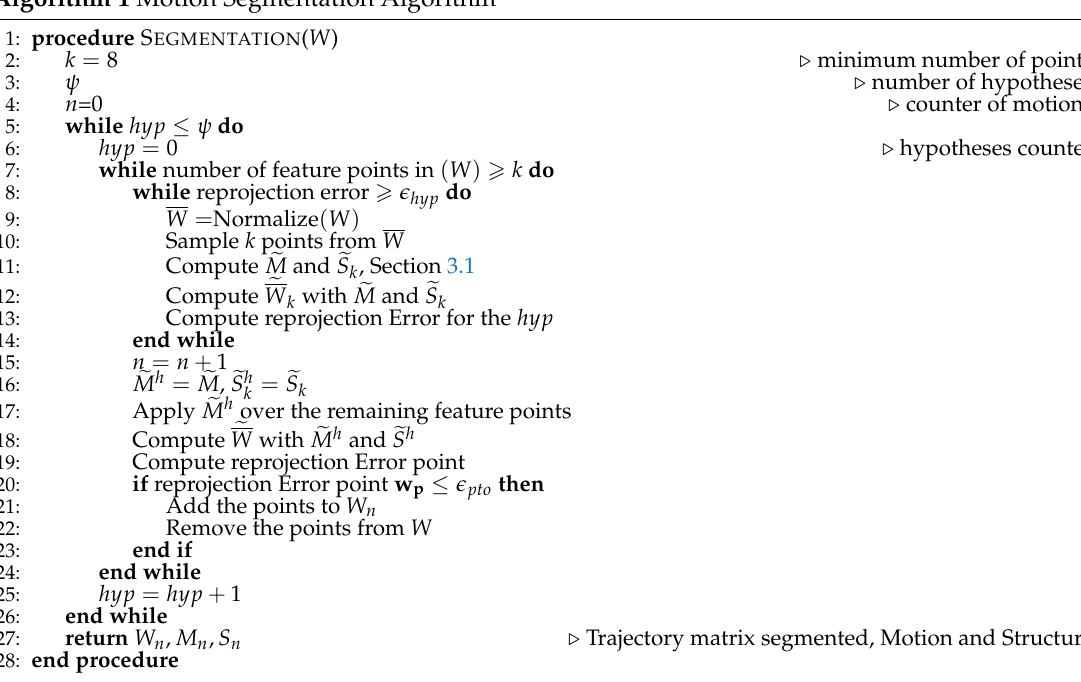
Algorithm 1 Motion Segmentation